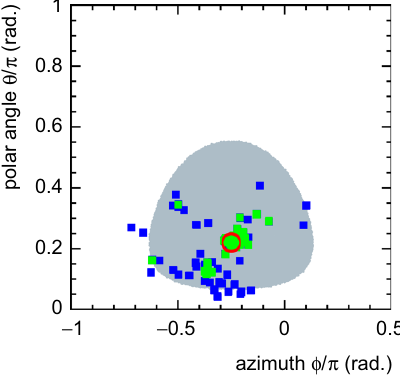
√ Fig. 9 Event display for a e + e − → t ¯ t event at s = 3 TeV. The left red circle. The area where the distance to the jet axis is smaller than the panel shows the result of clustering with the longitudinally invariant radius parameter ( (cid:4) R iC for longitudinally invariant k t , 1 − cos θ iC for k t algorithm with R = 1 . 2, the right panel the corresponding VLC jet VLC) is indicated by the shaded region. The green squares represent particles from the top decay that are associated with each jet, the blue with the same radius parameter. The image zooms in on the θ − φ area squares to background particles clustered into the jet around one of the top jets. The location of the jet axis is indicated as a